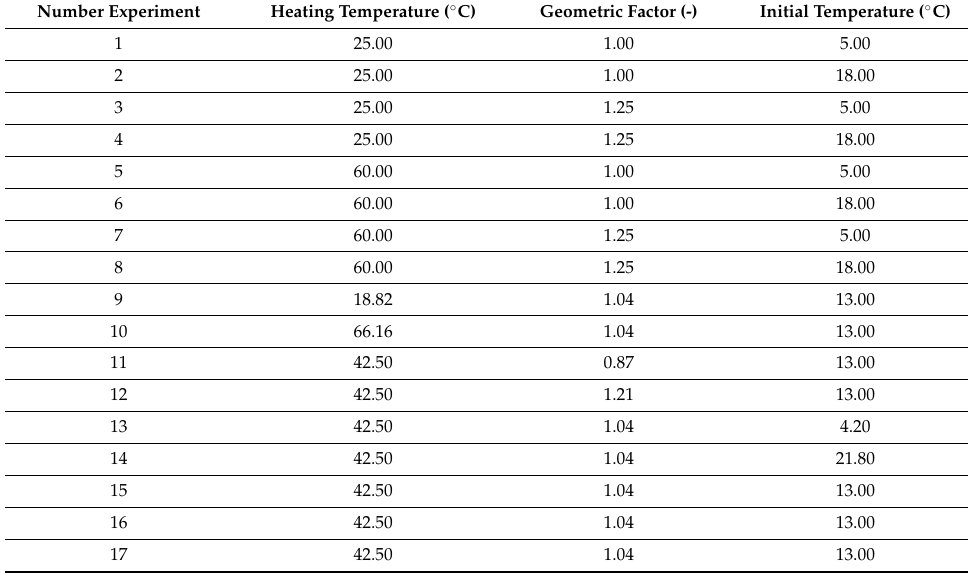
Table 4. List of the required experiments per the experimental design shown in [41] from Statistica